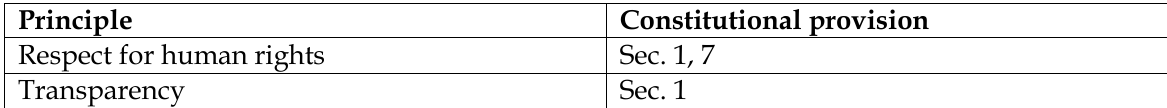
Table 2: Key international principles compared with SA